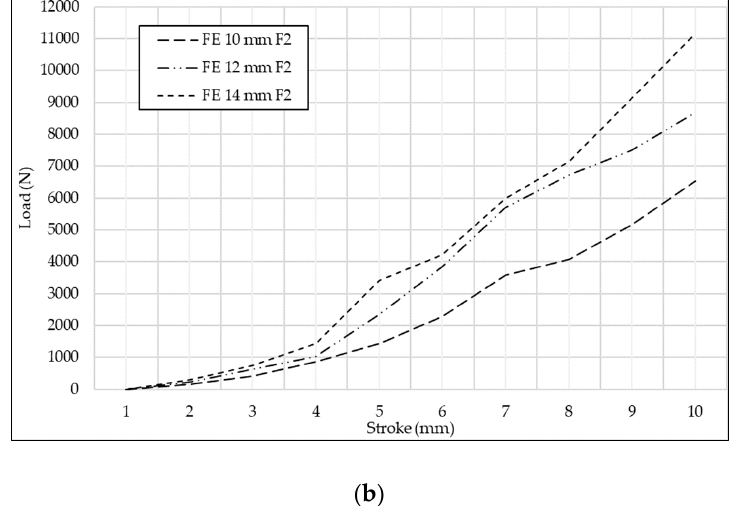
for form1, form2, and form3, respectively. The percentage errors between the experi- mental and FEA 7.4, 5.1, and 2.4% were calculated for the three forms, respectively. Figure 14. Forming load–stroke graphs from numerical simulations of ( a ) form1; ( b ) form2; ( c ) form3. The experimental study was conducted using a 12 mm pin for the three forms. The forming load–stoke curves of the experimental study and the corresponding FEA results are shown in Figure 15. The maximum forming loads were 6805 N, 9142 N, and 4751 N